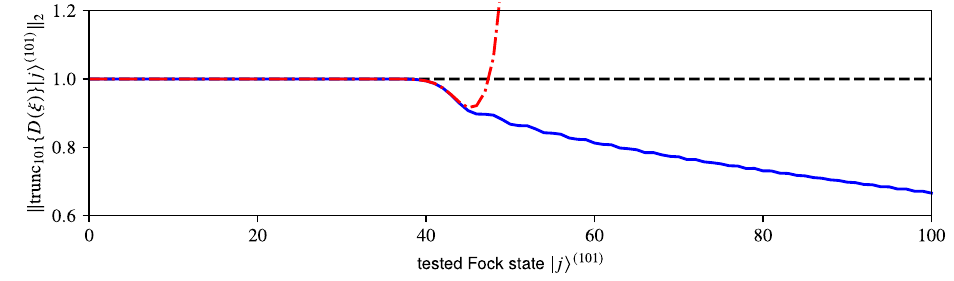
( 101 ) 100 . The j j with 0 ≤ ≤ (cid:31) (cid:30) (cid:31)